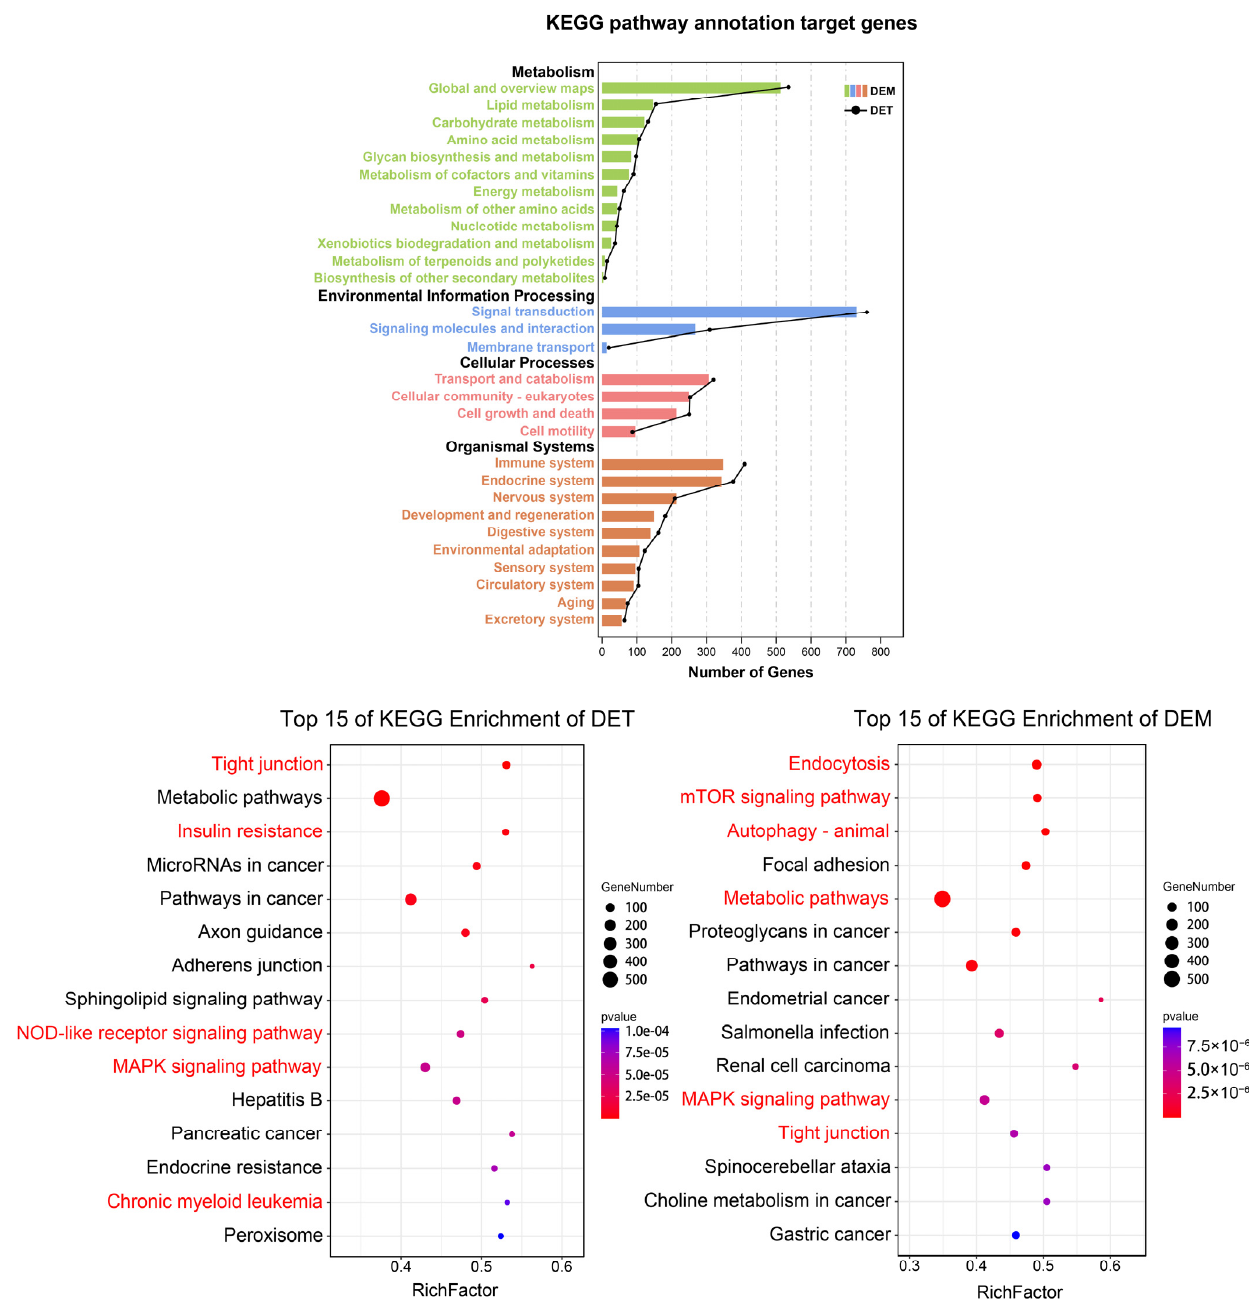
Figure 7. Kyoto Encyclopedia of Genes and Genomes (KEGG)-enrichment analysis for differentially expressed miRNAs and tsRNAs.